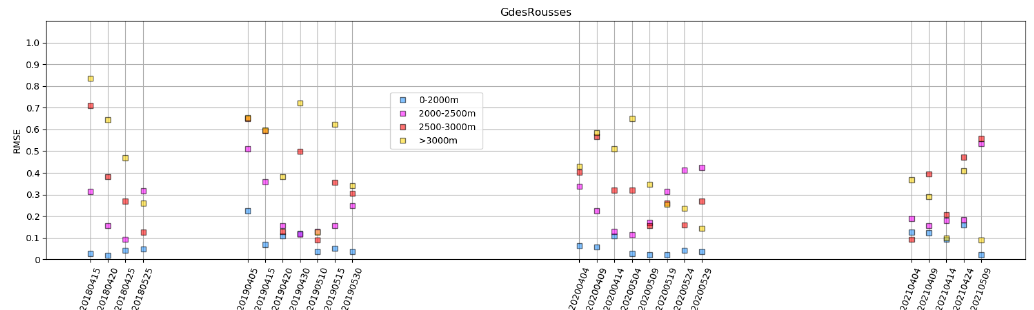
Figure 6. RMS errors for different dates of Sentinel-2 observations (April–May). At these dates, SWS products from ascending orbit closest in time to S2 are selected. The results are shown by altitude range (blue squares: 0–2000 m, pink squares: 2000–2500 m, orange squares: 2500–3000 m and yellow squares: >3000 m).